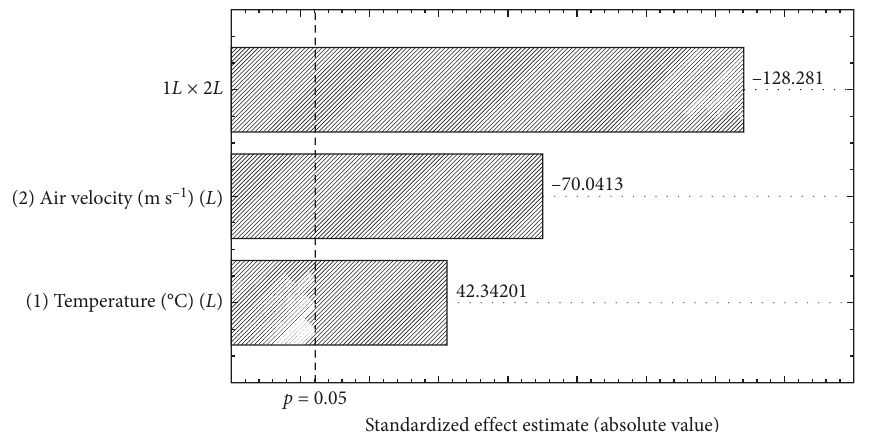
Figure 2: Pareto chart showing the effect of air temperature and velocity on the IC